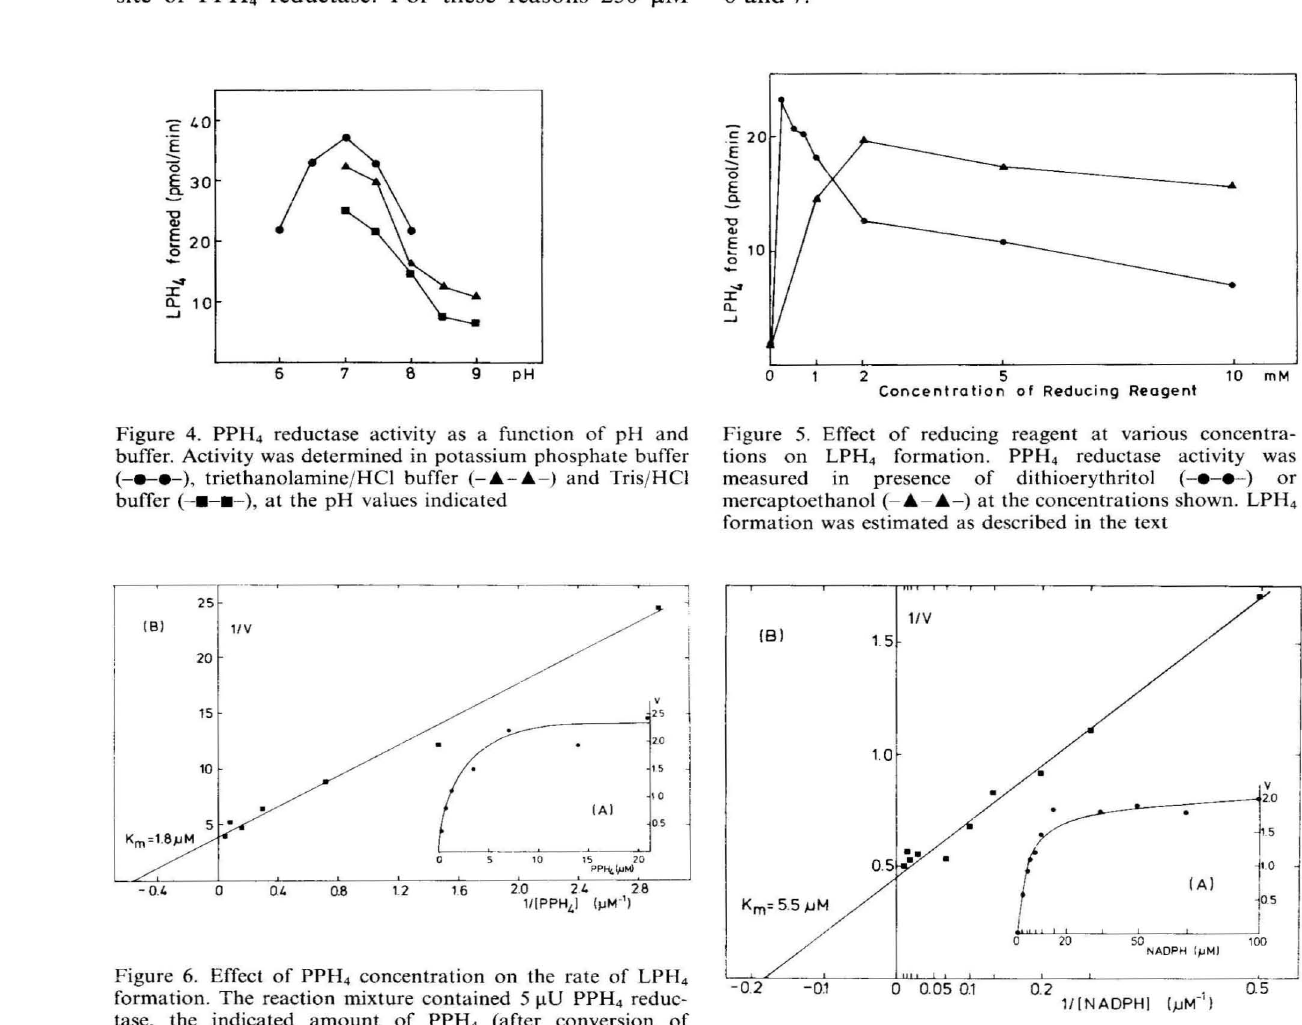
reduc 4 Figure 7. Effect of NADPH on the rate of LPH 4 formation. The reaction mixture contained 20 IlU of PPH 4 reductase and the indicated amount of NADPH. Other conditions were the same as described in Fig. 6, except that 20 IlM NII 2 TP were used. The reaction was stopped after 10 min and LPH 4 for mation was analyzed by HPLC with electrochemical detection. (A) linear plot of total LPH 4 formation (IlM): (B) double reciprocal plot of the same data Pteridines / VoL 1 i 1989 i